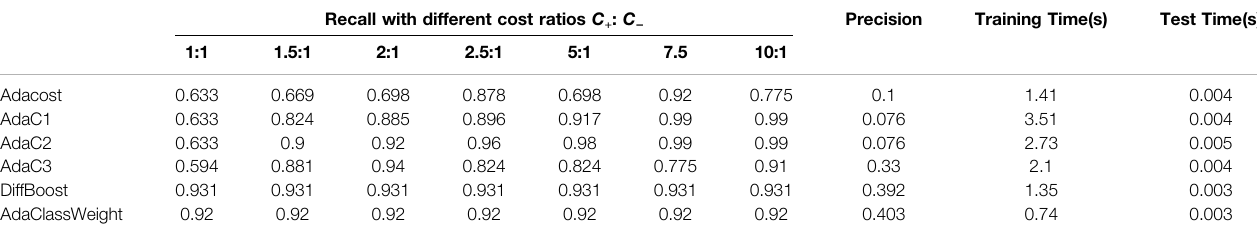
TABLE 4 | Spam data. From left to right: the recall on test data under various cost ratios, the precision corresponding to the highest recall, training time, and test time. Recall with different cost ratios C + : C − Precision Training Time(s) Test